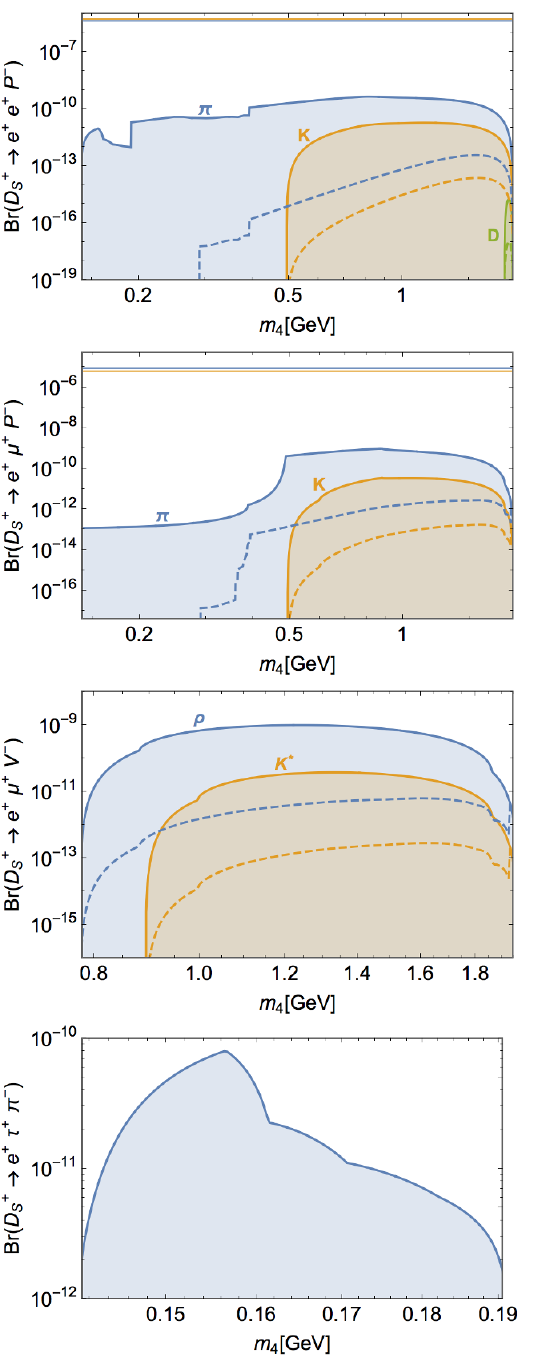
Figure 13 . Branching ratios of LNV decay modes of D + (cid:12)nal states, plus leptons of same or di(cid:11)erent (cid:13)avour), as a function of the (mostly sterile) heavy neutrino mass, m 4 . Line and colour code as in (cid:12)gures 8 and 9.